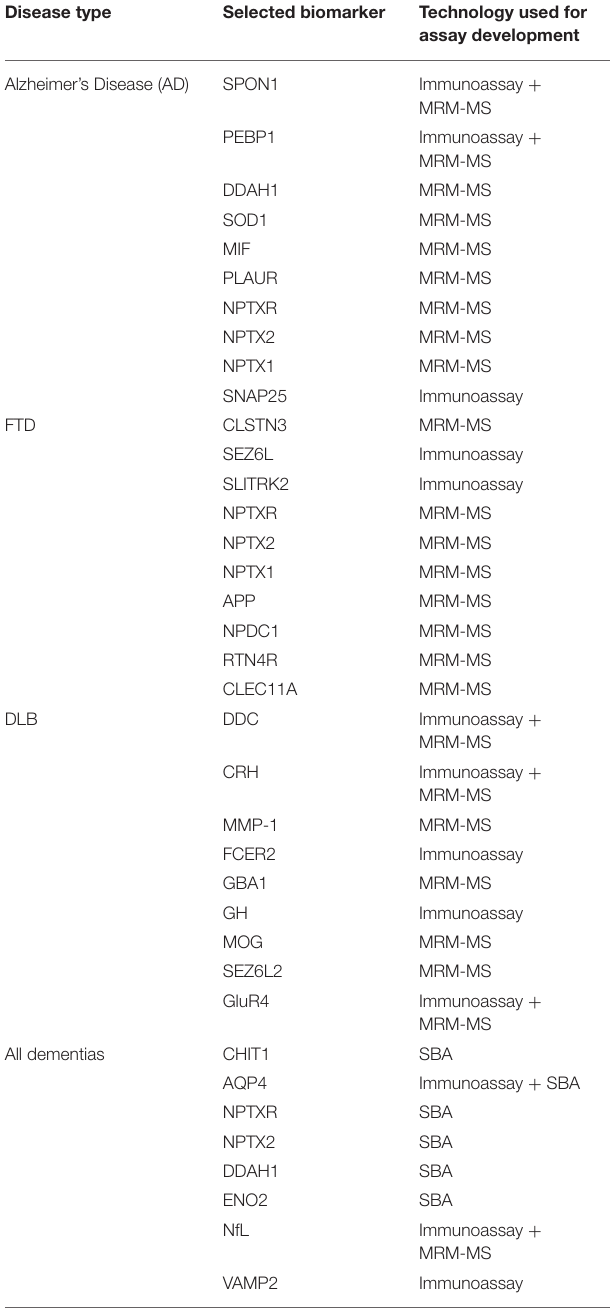
TABLE 1 | Novel biomarkers selected for assay